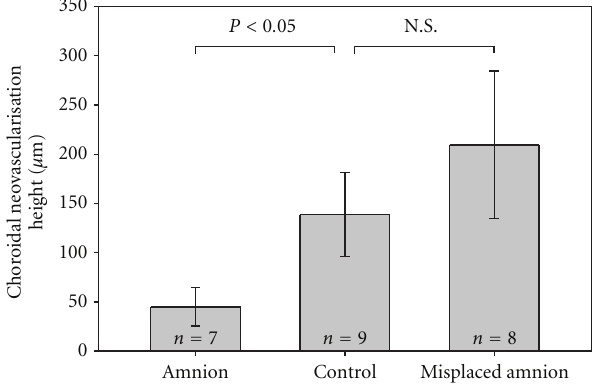
Figure 2: Graph of maximal height in induced choroidal neovas- cularisation measured in um. Experiments were divided in success- ful (amnion), unsuccessful (misplaced amnion), and control (no amnion). Data are presented as mean +/ − SD. Kruskal-Wallis one- way analysis of variance on ranks was